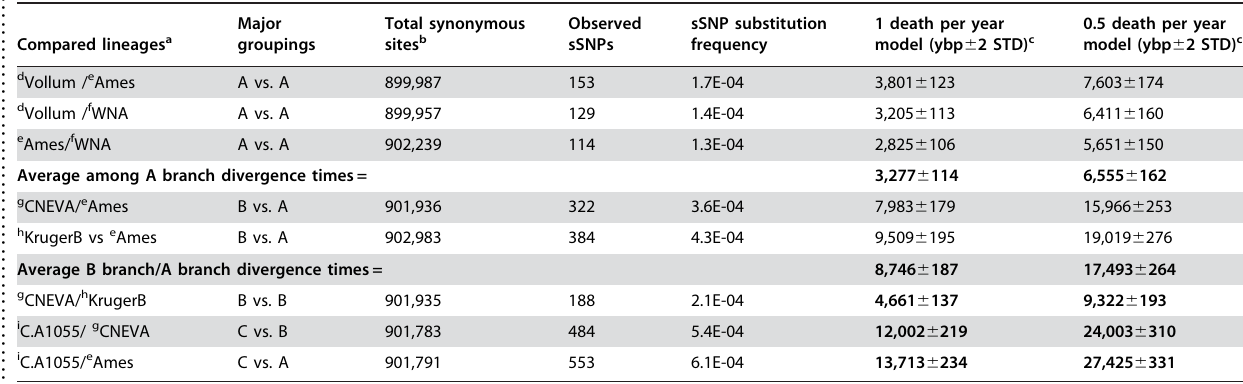
Table 2. Molecular clock estimates of separation times among B. anthracis sub-lineages. .. ... .... ... ... .... ... ... .... ... ... .... ... ... .... ... ... .... ... ... .... ... ... .... ... ... .... ... ... .... ... ... .... ... ... .... ... ... .... ... ... .... ... ...